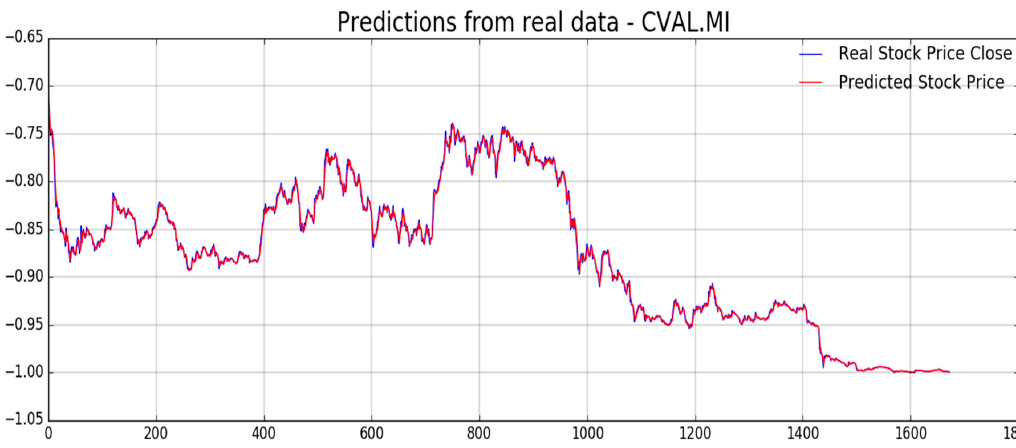
Figure 16. CVAL.MI Close Price time-serie (red: predicted; blue: real value).